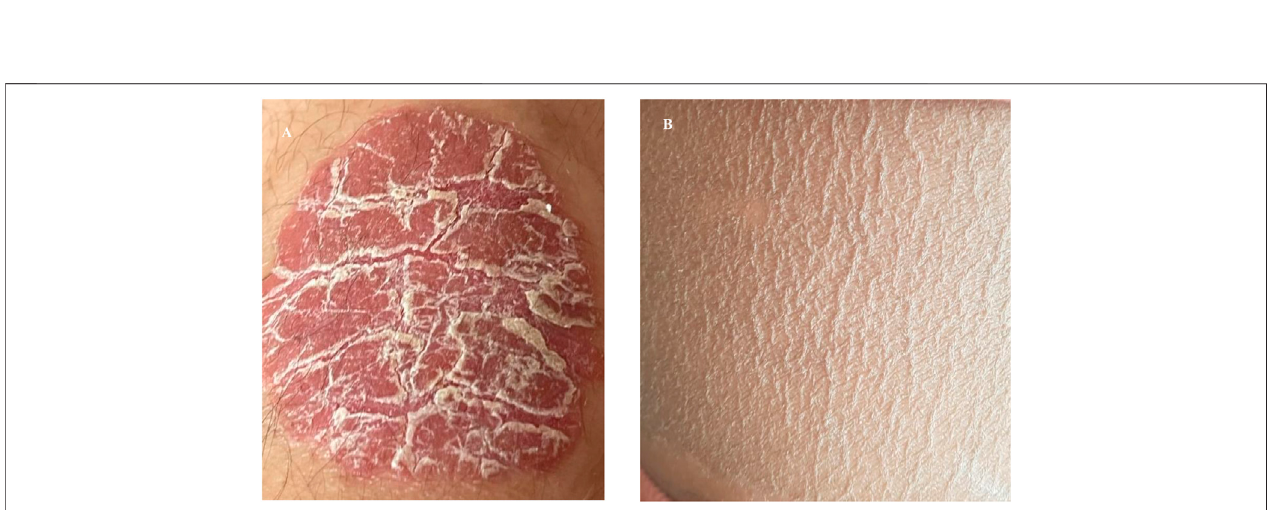
FIGURE 4 | Examples of skin changes seen in SRD5A3-CDG. (A) Well demarcated erythematous and scaly plaque classical of psoriasis seen in patient 1 – 1. (B) Excessively dry scaly skin representative of ichthyosis seen in patient 1 – 2 who was born as a collodion baby.